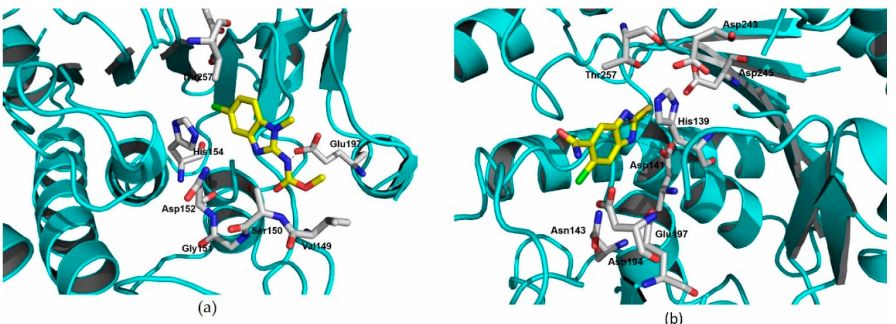
Figure 6. Ligand interactions in LmARG-inhibitor complexes after 30 ns of MD simulation. ( a ) compound 1 and ( b ) Compound 2 . Both inhibitors are represented as yellow sticks for the C atoms. Relevant residues surrounding the inhibitor are depicted as capped sticks and labeled. Predicted polar interactions (Glu197 and Asp141, respectively) depicted dashed lines.